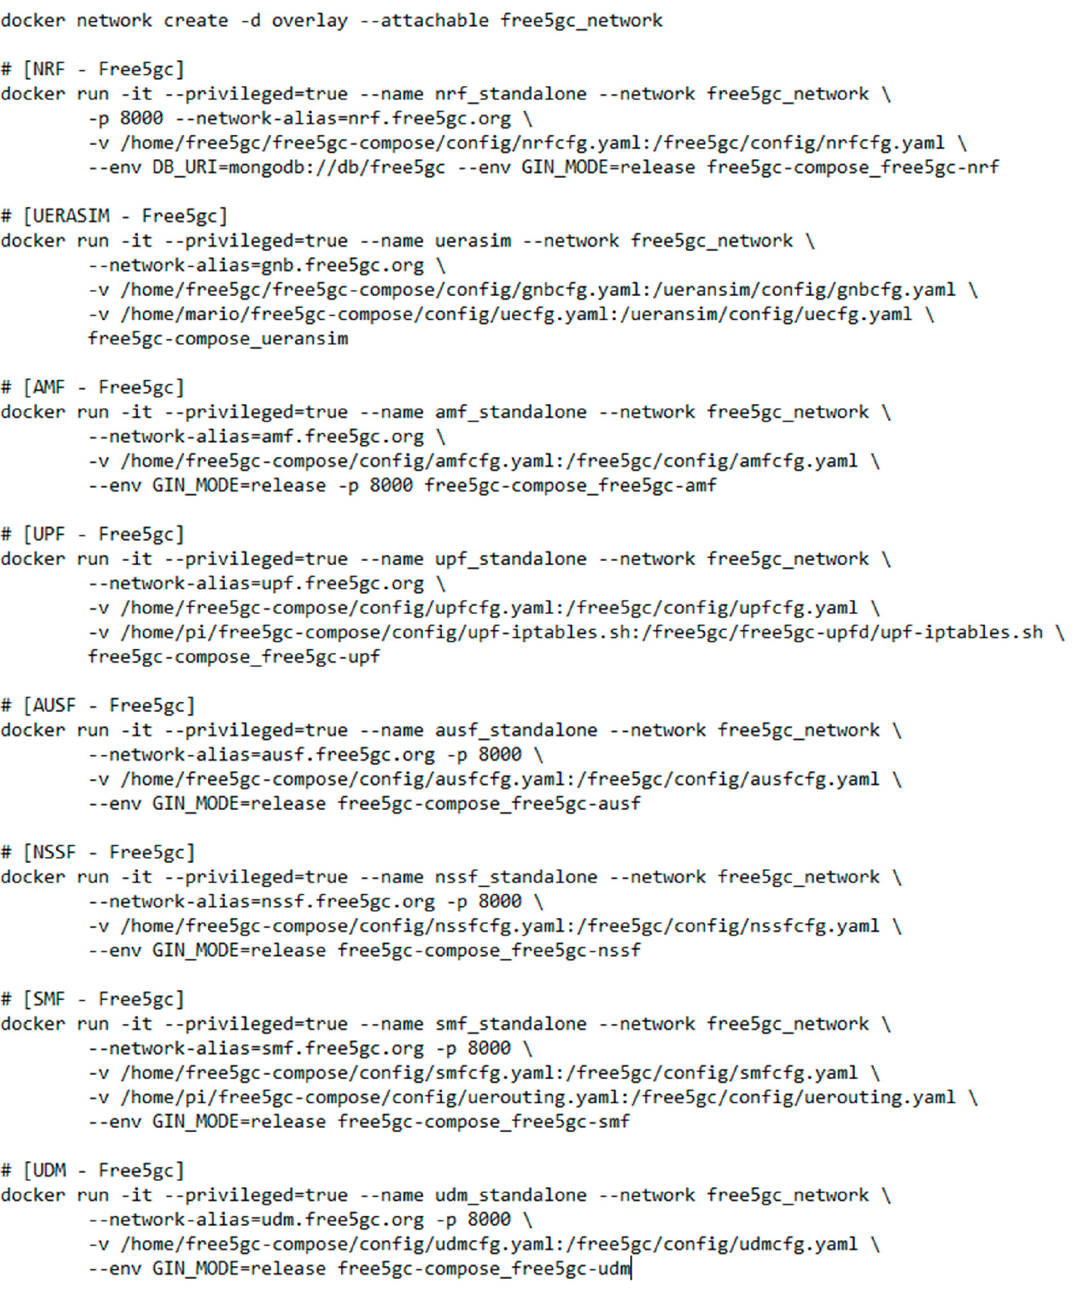
Figure 5. Example of distributed provisioning 5G Core via Docker.